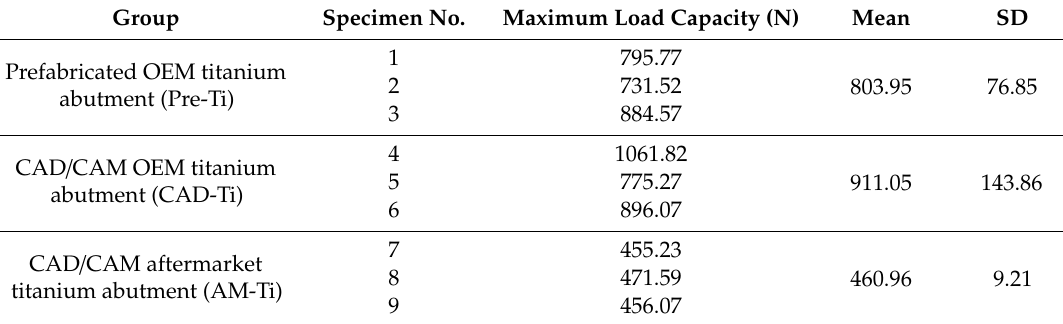
Table 1. Maximum load capacity of titanium abutments (n = 3).